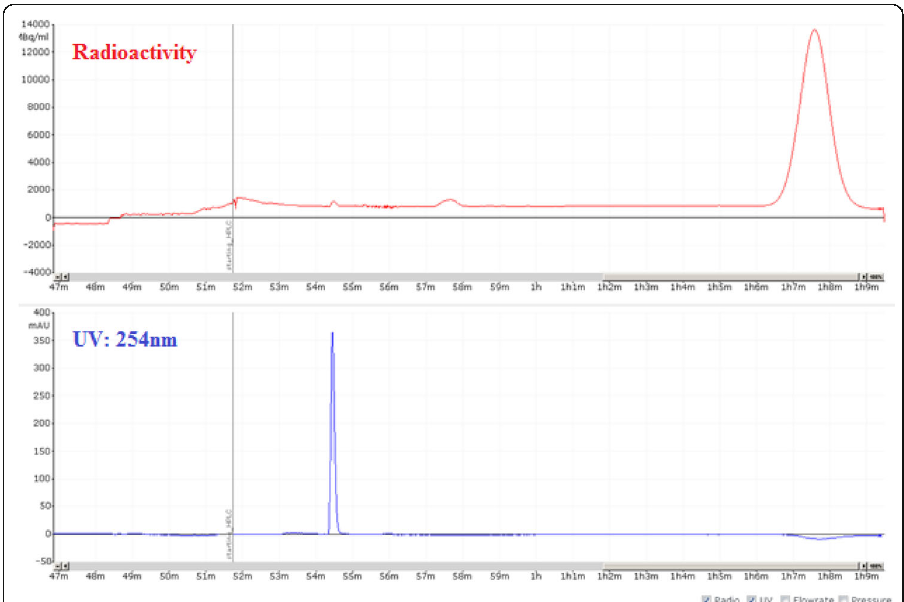
Fig. 10 A view of typical semi-preparative chromatogram of [ 18 F]FTT